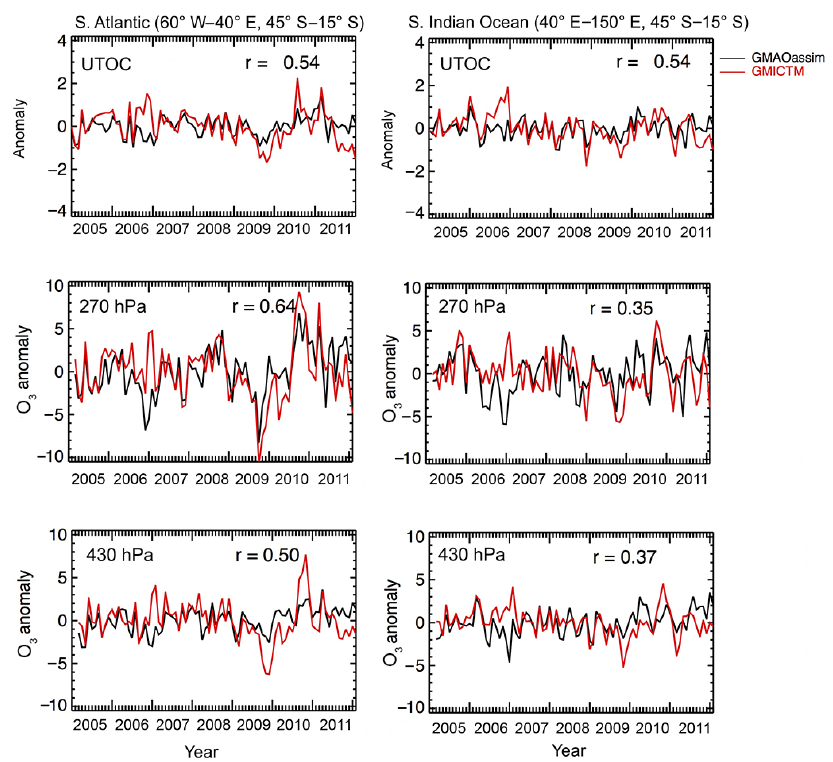
Figure 5. Time series plots of upper tropospheric ozone column (UTOC, integrated from 500hPa to the tropopause; unit: DU) anomalies and tropospheric ozone anomalies (unit: ppb) at 270 and 430hPa from GMAO assimilated data (black) and GMI-CTM (red) over (left) the South Atlantic (60 ◦ W–40 ◦ E, 15–45 ◦ S) and (right) South Indian Ocean (40–150 ◦ E, 15–45 ◦ S) from 2005 to 2011. The anomalies are calculated by removing the monthly mean averaged from 2005 to